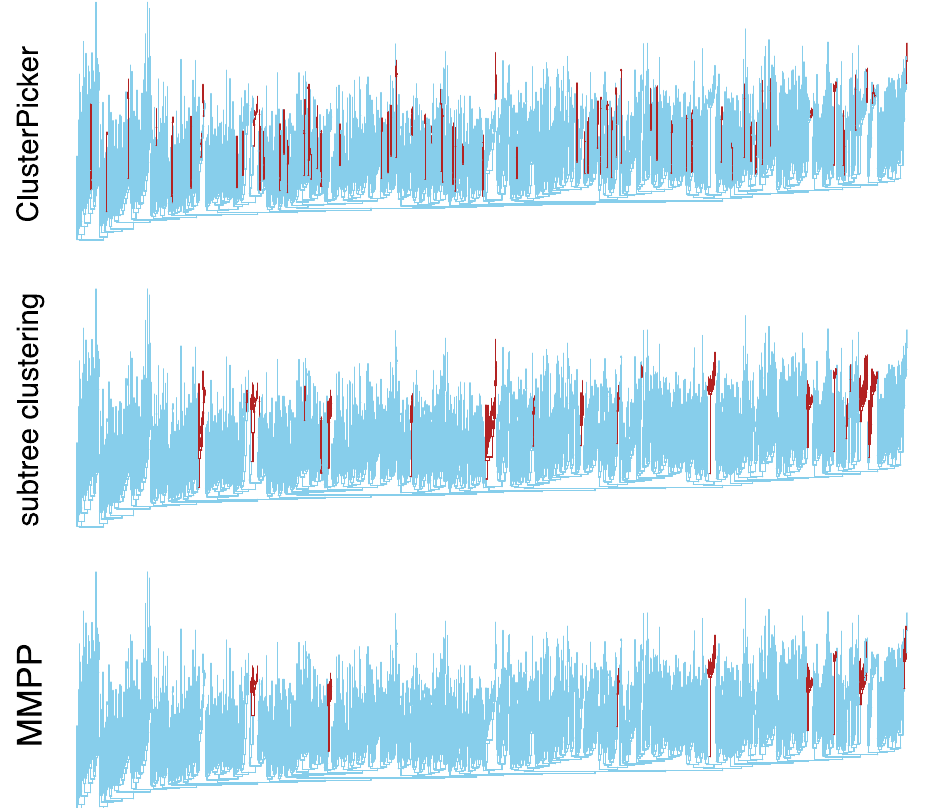
Fig 4. Comparison of three different clustering methods applied to a phylogeny reconstructed from real HIV data. The phylogeny was reconstructed by maximum likelihood from a published data set of HIV-1 subtype B pol sequencesfrom a recent study of geneticclusters in Seattle, U.S. [38]. We adjustedthe ClusterPicker and subtree clusteringmethod parameters until the number of individuals assignedto clusters was similar to the number reportedin the originalstudy. For instance,the subtree method was used with a mean branch length cutoff of 0.65% and a bootstrapcutoff of 90%. Branches assignedto clusters are highlightedin dark